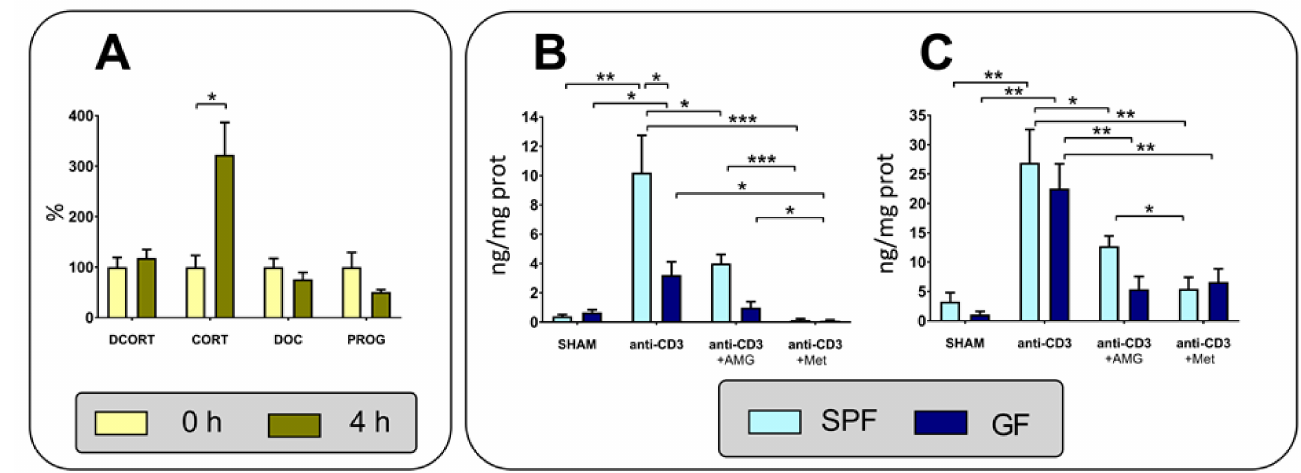
Figure 4. Ex vivo steroid production by intestinal tissue. ( A ) Changes in the levels of 11-dehydrocorticosterone (DCORT), corticosterone (CORT), progesterone (PROG) and 11-deoxycorticosterone (DOC) in tissue explants after 4 h incubation in tissue culture. ( B ) Effect of the anti-CD3 antibody, aminoglutethimide (AMG) and metyrapone (Met) on the level of corticosterone. ( C ) Effect of the anti-CD3 antibody, AMG and Met on the level of 11-dehydrocorticosterone. Specific pathogen-free (SPF) and germ-free (GF) mice were injected with saline (SHAM) or the anti-CD3 antibody and sacrificed 4 h later, and the intestinal fragments were cultured ex vivo in the presence or absence of AMG or Met for 4 h. * p < 0.05; ** p < 0.01; *** p <